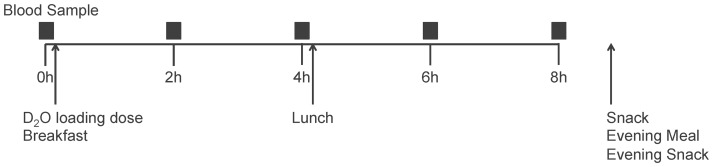
Schematic of the testing day design.Blood samples were taken at fasting (0 h) and every 2 h for 8 h after the D2O administration and breakfast completion. A lunch meal was provided after the 4 h sample, and take-away foods were provided for the subject to consume at home during the evening, before returning the following morning for a fasting 24 h blood sample.